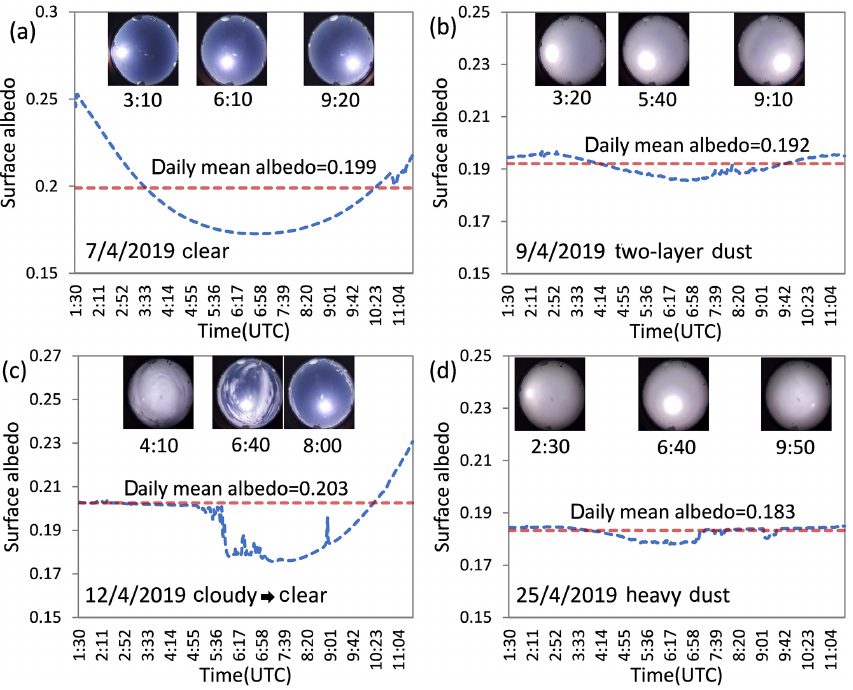
Figure 3. Diurnal variations of blue-sky albedo and corresponding full-sky visible images under different sky conditions at Kashi: (a) clear case, (b) two-layer dust case, (c) clouds early/clearing late case, and (d) heavy dust